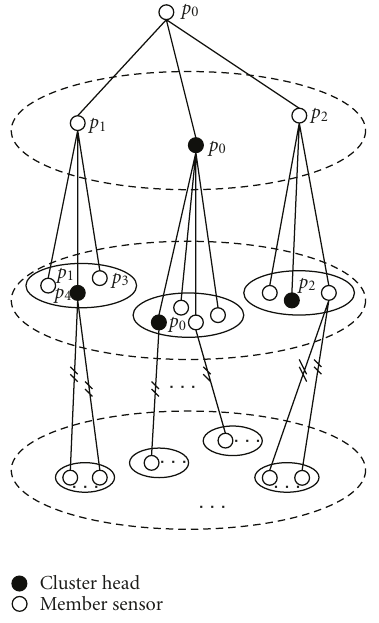
Figure 1: Hierarchical